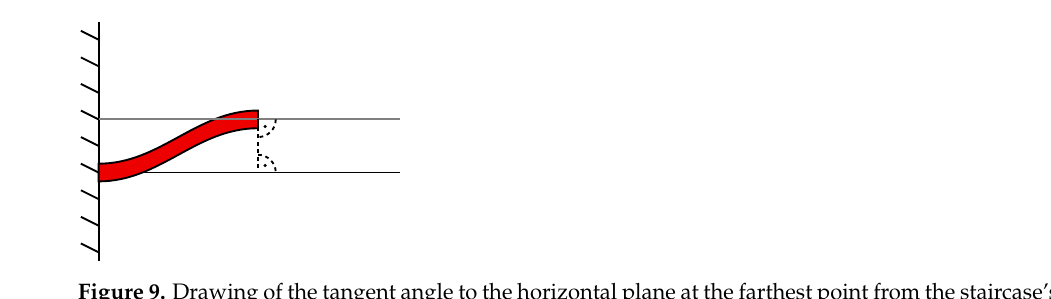
Figure 9. Drawing of the tangent angle to the horizontal plane at the farthest point from the staircase’s suspension.